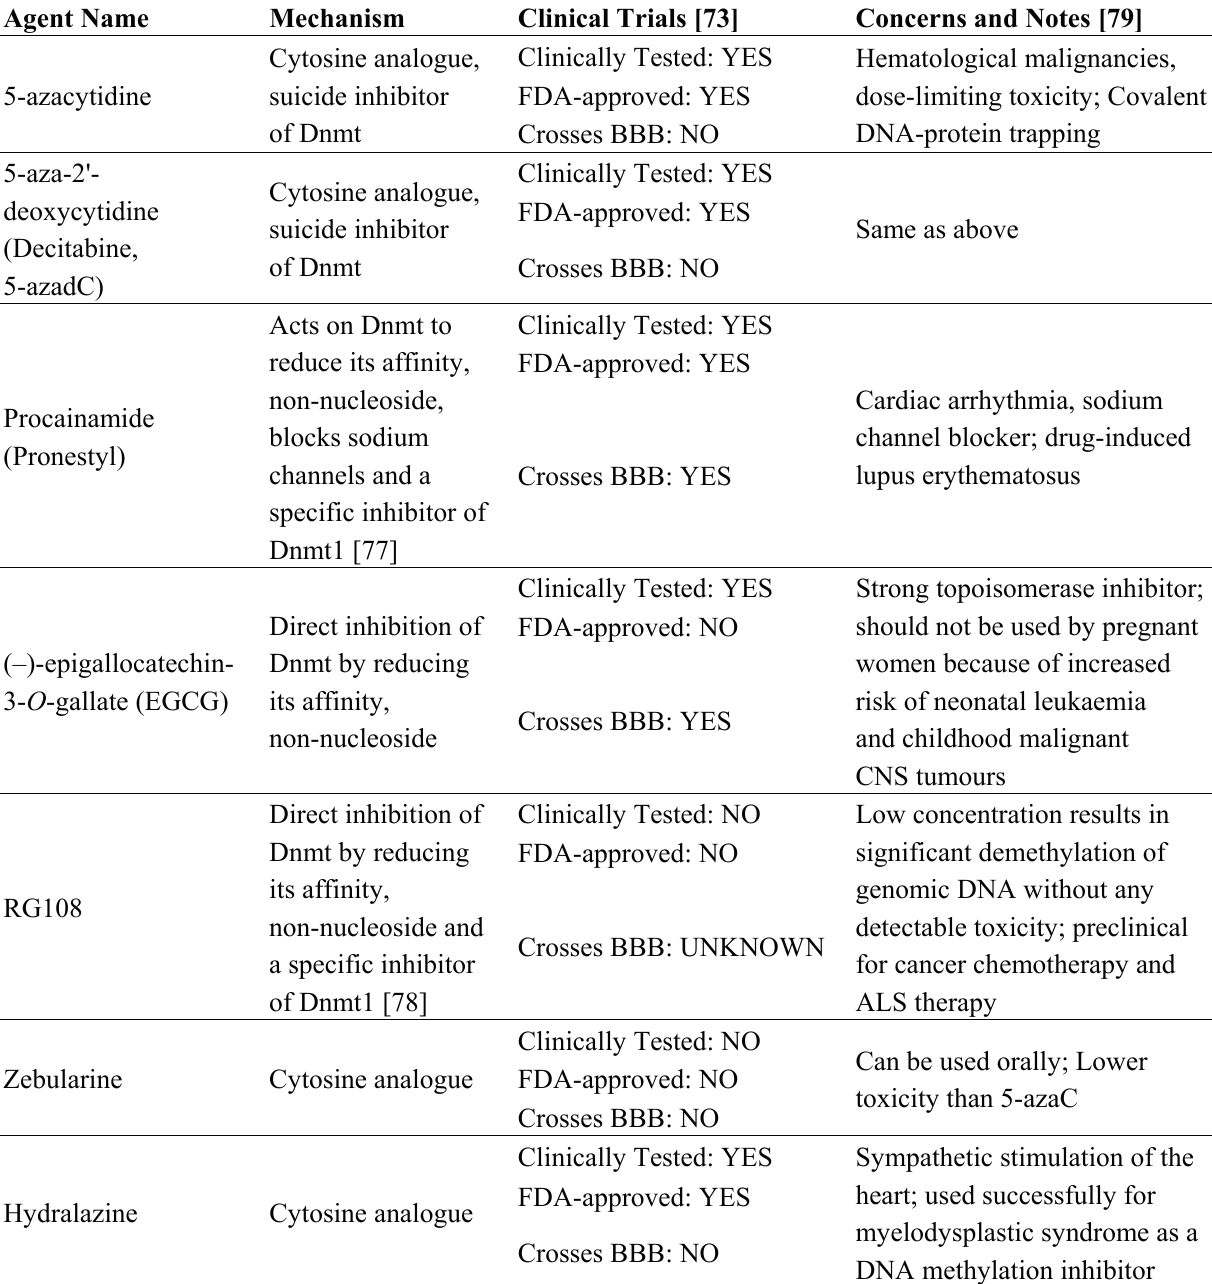
Table 2. DNA methylation inhibitors as possible therapies for neurodegenerative